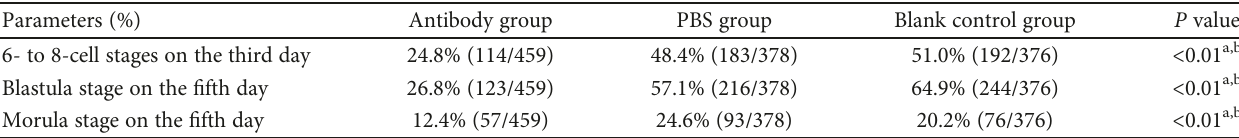
Figure 1: Immuno fl uorescence views of embryos cultured with anti-CENP-A antibody (original magni fi cation × 400). Antibody fl uorescence was present on the nuclei of blastomeres in embryos from the antibody group, while no signi fi cant antibody fl uorescence was observed in the embryos from groups of PBS, blank control, and antibody group for Table 1: Embryotoxicity assay.